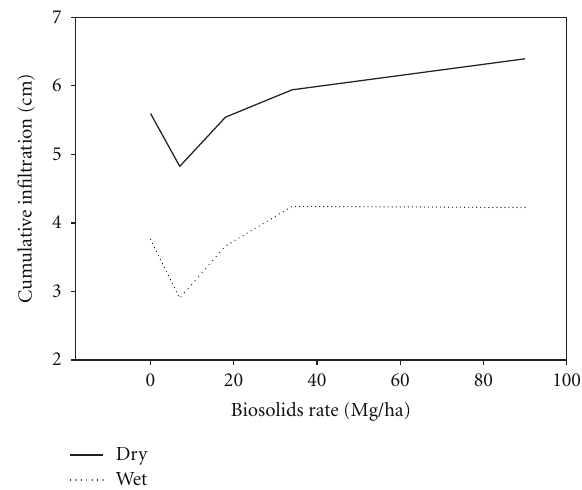
Figure 8: Cumulative infiltration for wet or dry conditions in vegetated treatments for the Stellar soil as a function of biosolids rate on the Sierra Blanca